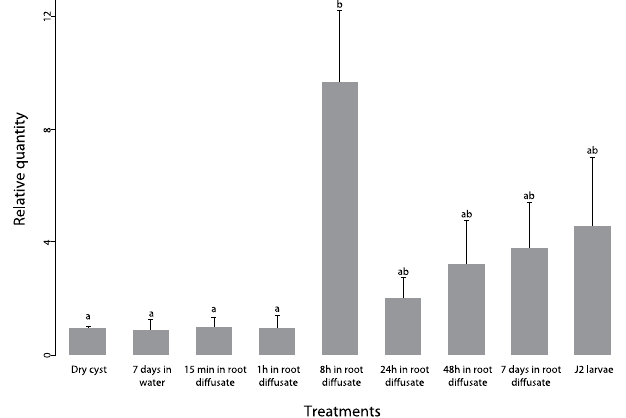
Figure 2. Expression of neprilysin gene nep-1 by RT-qPCR in dry cysts, hydrated eggs, and hydrated eggs exposed to potato root diffusate (PRD) for 15 min, 1 h, 8 h, 24 h, 48 h and 7 days and hatched J2. Hydrated cyst expression level was use as calibrator. Error bars represent standard error of the mean and significant differences among treatments are indicated by different letters